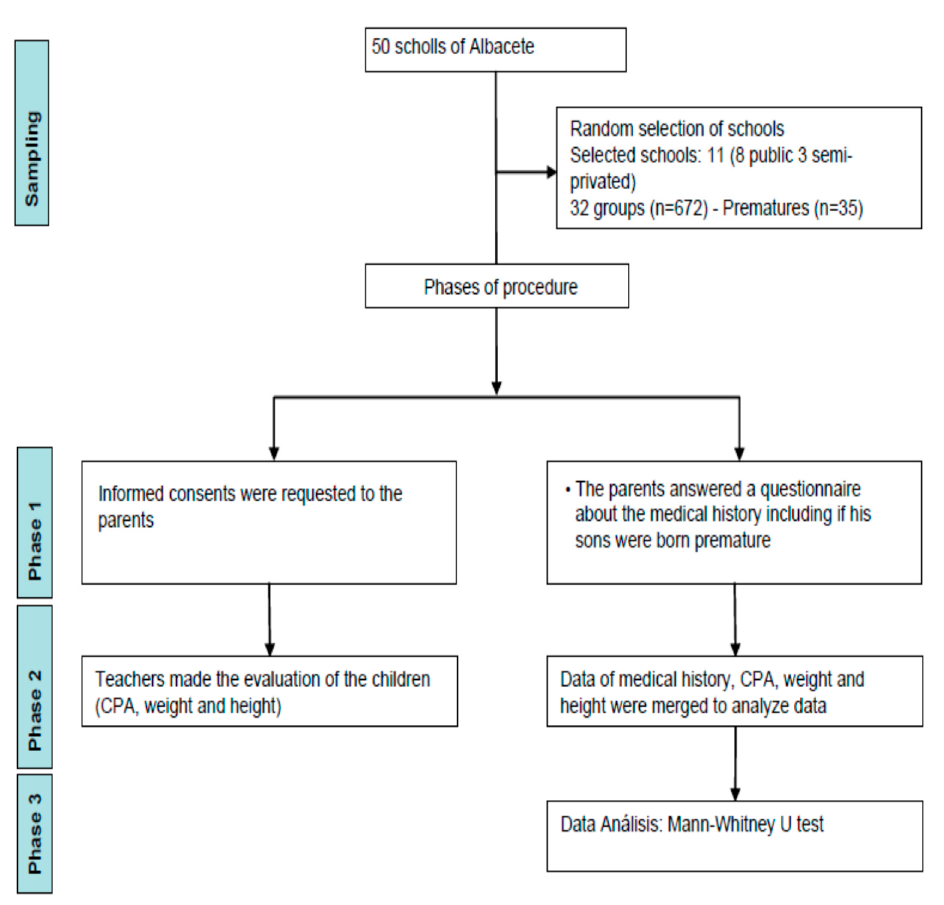
Figure 1. Phases of the procedure and sampling. Note: CPA = Checklist of Psychomotor Activities. In total, 46.7% of the sample were girls and 53.3% were boys. We found that 5.2% of the total sample ( n = 35) were born preterm in 2012; this information matches with the reports of Save the Children and the World Health Organization, stating that the rate in Spain was 7.14 out of 100 preterm births in the same year [20]. Prematurity definition for this study is considered in the above-mentioned reports (children born before week 37). World Health Organization classification [21] for 5-year-old boys: severely underweight (<12.1 kg/m 2 ), underweight (12.2–12.9 kg/m 2 ), normal weight (13–16.6 kg/m 2 ), over- weight (16.7–19.9 kg/m 2 ), and obese ( ≥ 20 kg/m 2 ), and for 5 years old girls: severely under- weight (< 11.8 kg/m 2 ), underweight (11.9–12.6 kg/m 2 ), normal weight (12.7–16.9 kg/m 2